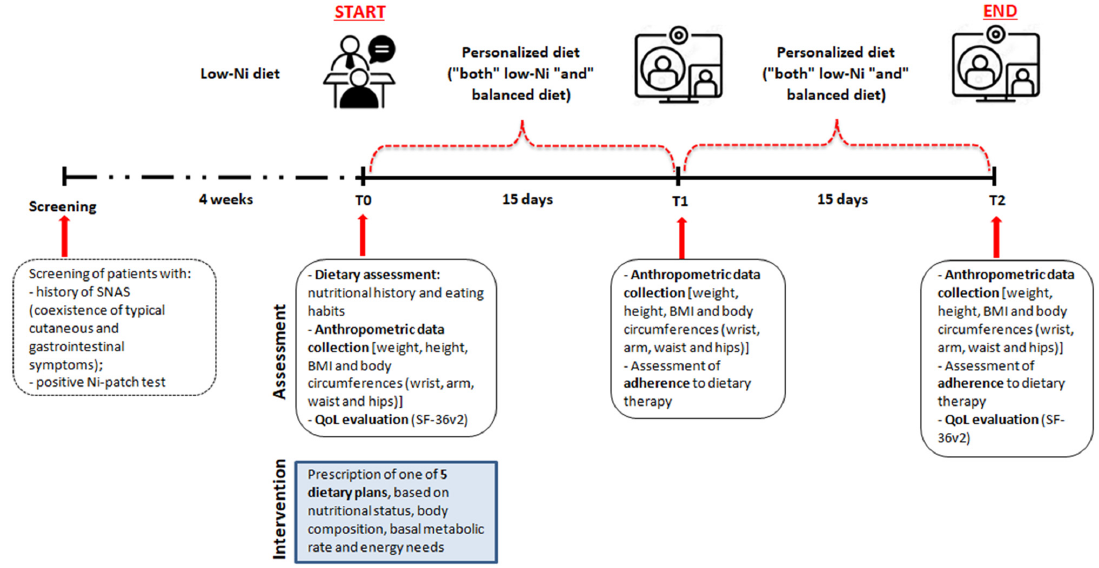
Figure 1. Flow-chart of the study.